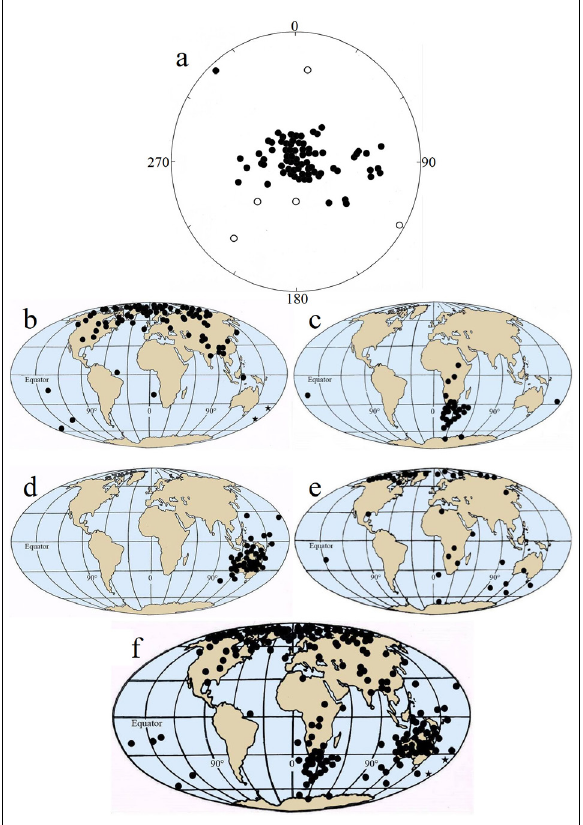
Figure 8: (a) Stereographic projection of virtual geomagnetic poles (VGPs) calculated from directions of characteristic remanent magnetisations isolated in the Rose Cottage site. Solid circles show those ones located in the northern hemisphere. The centre of the projection is the Geographic Southern Pole. (b) VGPs paths plotted on a world map for the RC section. The stars show the VGPs calculated from the secondary direction of RC75 and RC76. Examples of VGPs location from samples with anomalous directions recorded during the Pleistocene–Holocene transition and early Holocene in some sites from different places of the world: (c) El Tingo (Ecuador), (d) Barrancas de Maipú (Argentina) and (e) Mylodon Cave (Chile). (f) The totality of VGPs from the locales illustrated in (b–e). Modified with permission after Nami et al. 55,56 and Nami 60